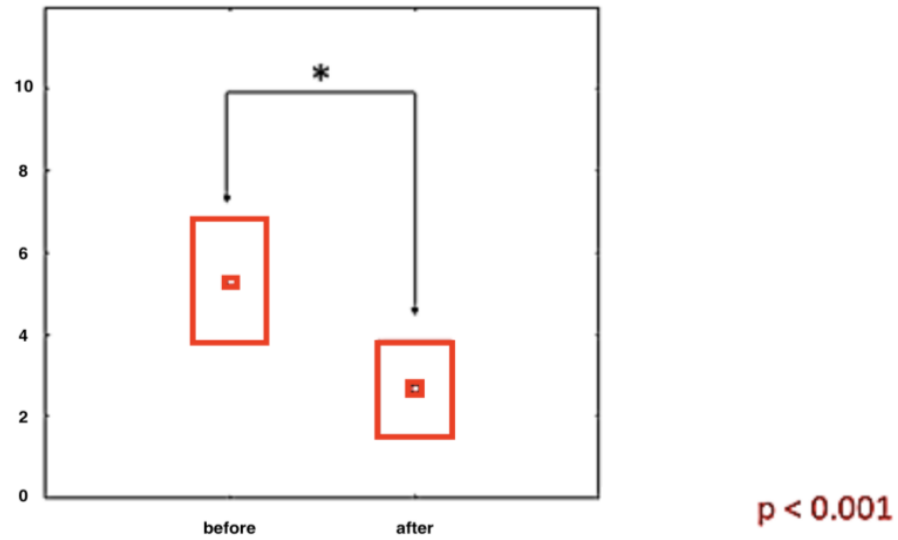
Figure 1. The magnitude of VAS pain intensity in patients from all groups collected together before and after treatment (results in cm). *—statistically significant.